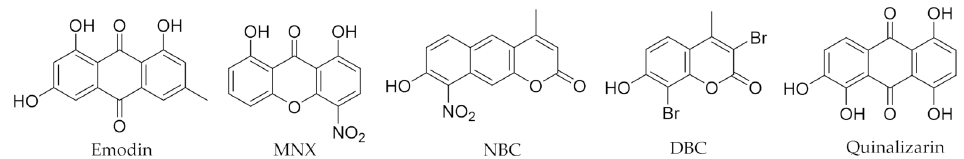
Figure 5. Structures of polyphenolic ATP-competitive inhibitors of CK2: emodin, MNX, NBC, DBC and quinalizarin